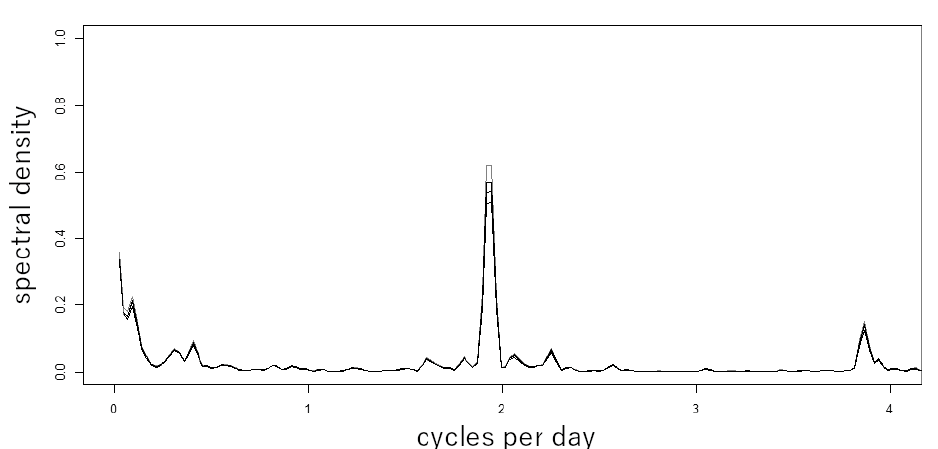
Figure A1. Plot of the periodogram of the total current speed (1 mab) from the BoBo lander stations.